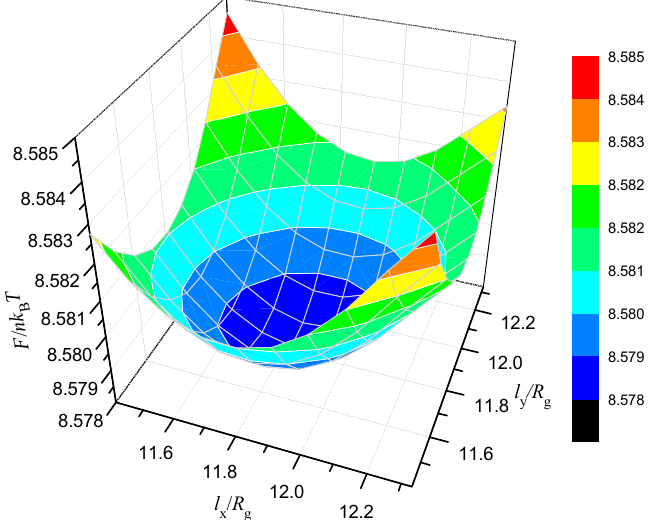
Figure 1. Calculation method for optimising domain sizes in the bulk: optimised domain size for phase point in bulk with χ ij N = 35 and f A : f B : f C = 0.2:0.6:0.2; free energy as a function of l x and l y , where l x and l y are the sizes of simulation box along the x- and y-directions, correspondingly.